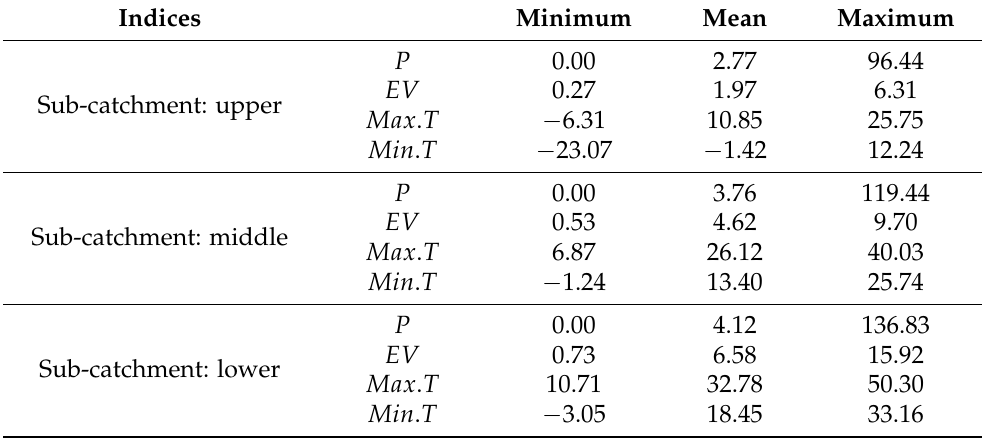
Table 1. Summary statistics of the P (mm/day), EV (mm/day), and T ◦ C for the Pong sub- catchments.